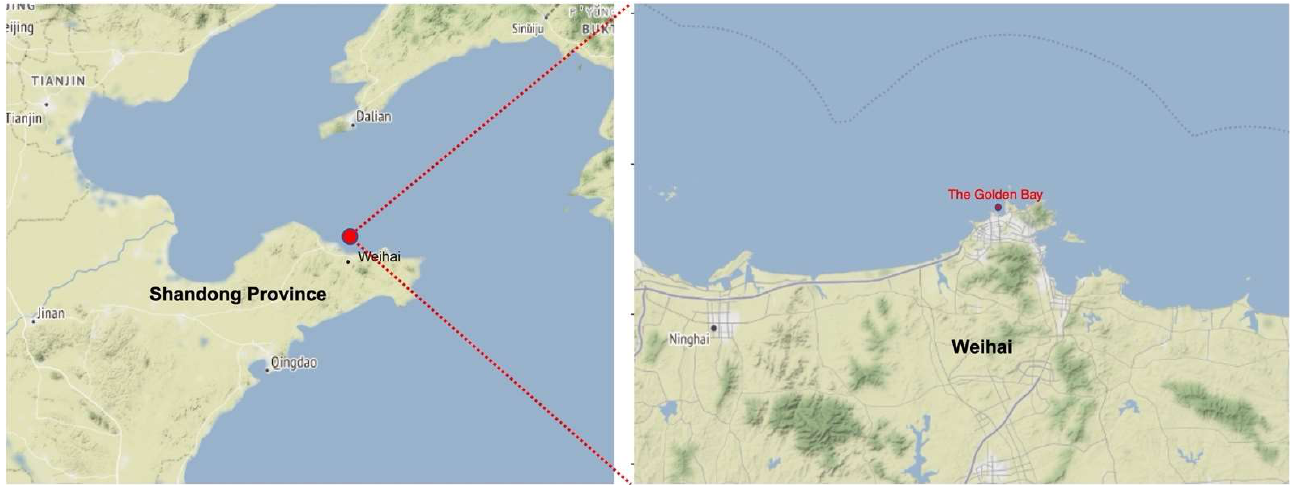
Figure 1. Map showing the sampling location in Weihai, eastern China.